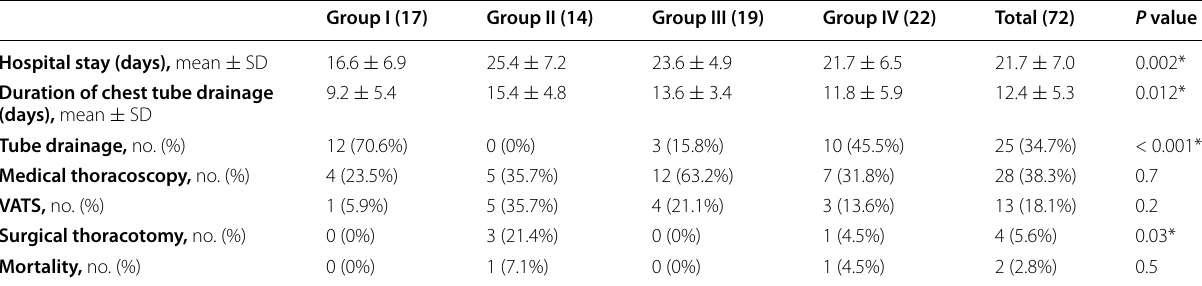
Table 3 Clinical course, treatment, and outcomes for thoracic empyema in different sonographic